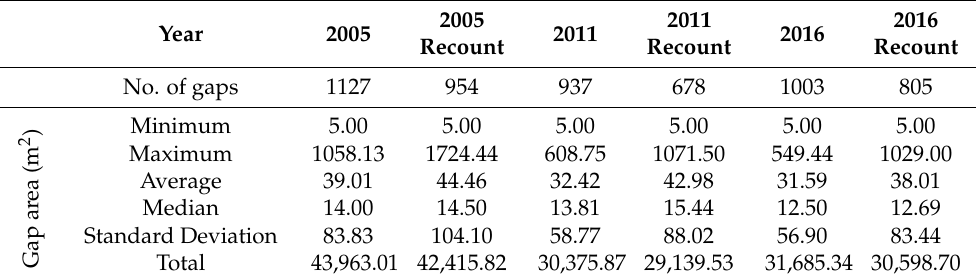
Table 3. Summary of gaps.